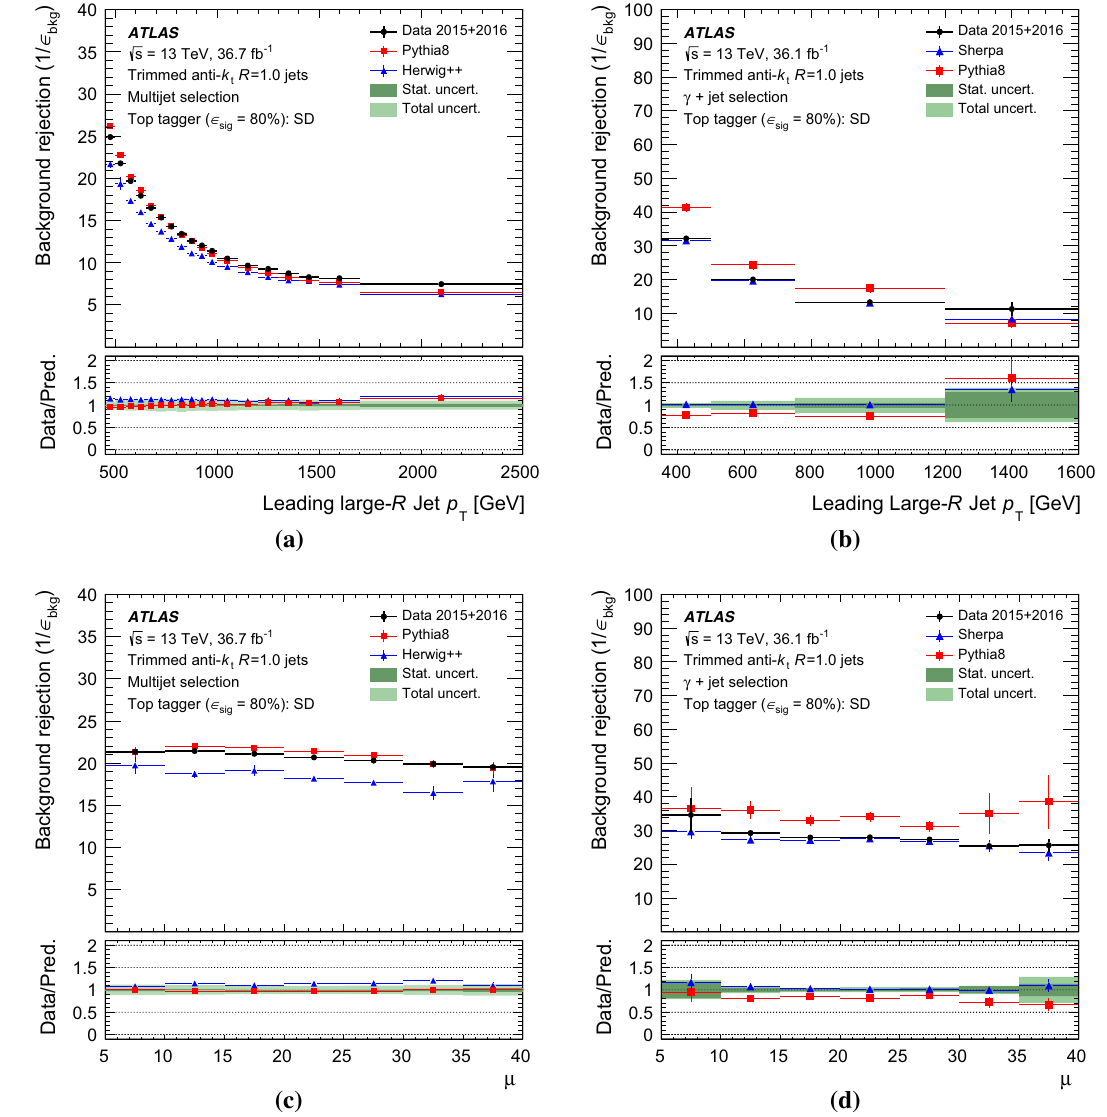
Fig. 38 The estimated light-jet rejection 1 /(cid:12) bkg as a function of the leading jet p T and the average number of interactions per bunch crossing μ for the shower deconstruction top-quark tagger in the multijet ( a , c ) and γ + jet ( b , d ) selection